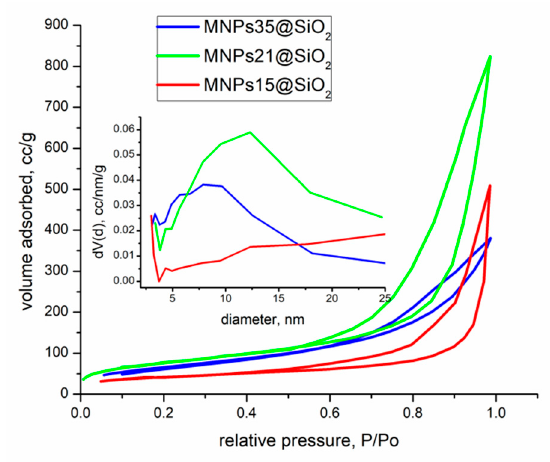
Figure 5. The N 2 adsorption-desorption isotherms of the magnetic nanocomposites. Inset: pore size distribution curves of the samples.